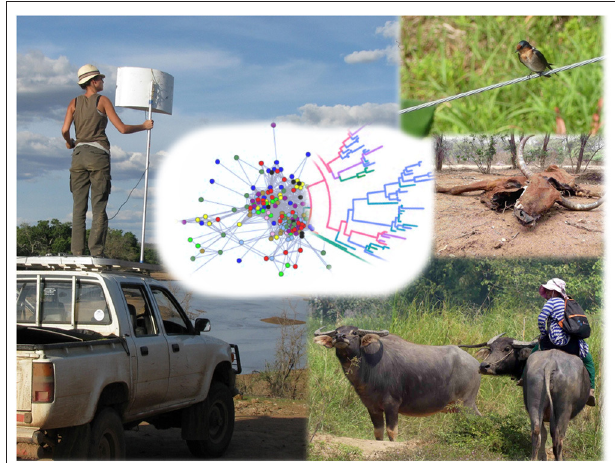
FIGURE 1 | Monitoring ecological and epidemiological interactions between willdlife, livestock and humans: radiotracking African buffalo in the Great Limpopo Transfrontier Conservation Area, Zimbabwe (left: picture by Eve Miguel/Michel de Garine-Wichatitsky); swallow in urban environment, Thailand (top-right: picture by Micha Garine-Wichatitsky); dead cow carcass, Southeast lowveld Zimbabwe (middle-right: picture by Michel de Garine-Wichatitsky); farmer riding a water buffalo in rural Cambodia (bottom-right: picture by Michel de